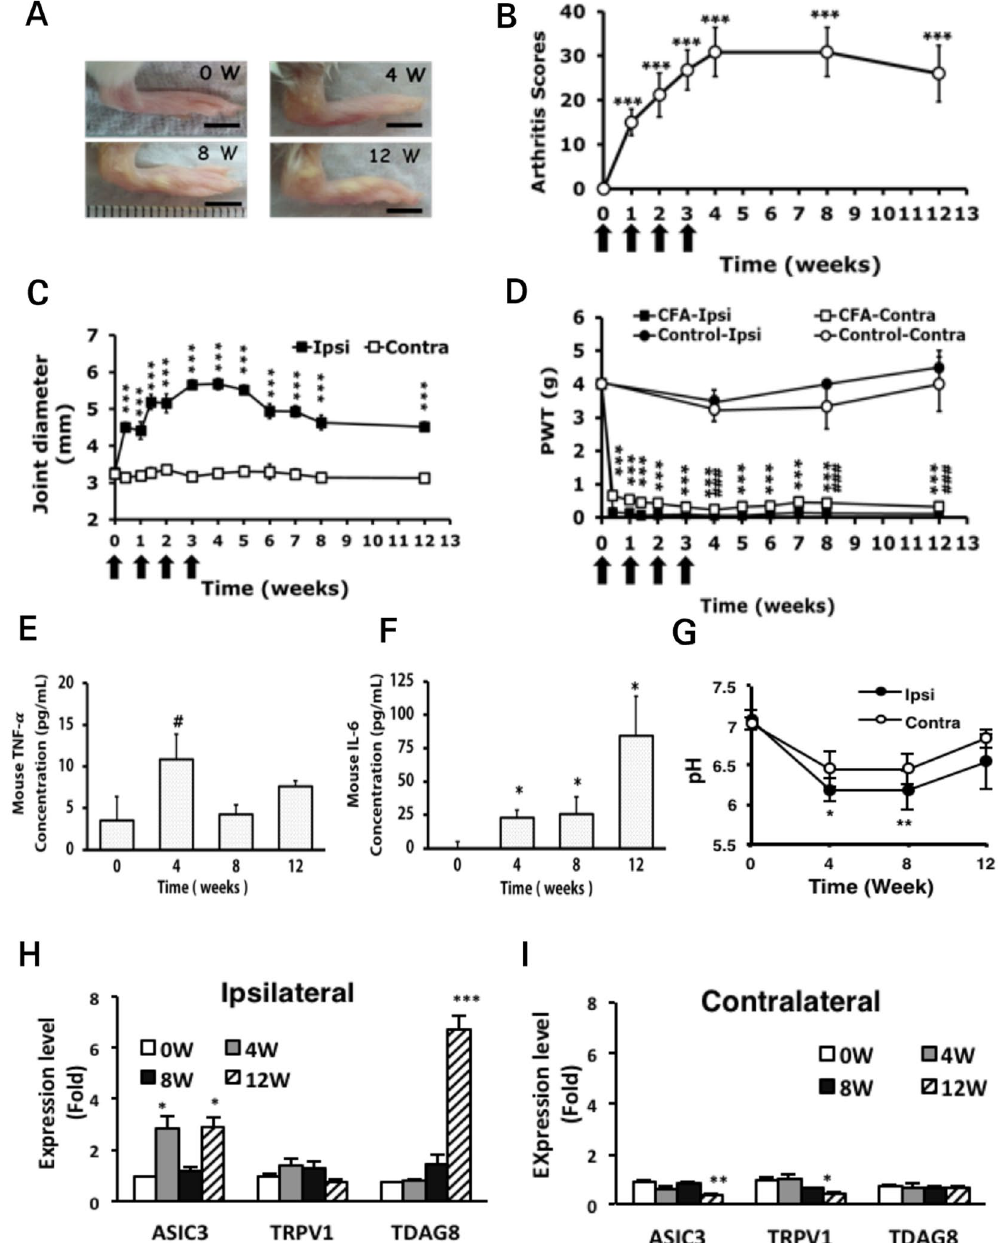
Figure 1. Arthritic ICR mice show long-lasting inflammation and bilateral mechanical hyperalgesia. Mice were injected with 5 μ g complete Freund’s adjuvant (CFA) in the right ankle joint (ipsilateral joint) once a week for 4 weeks. The joint swelling in 0, 4, 8, 12 weeks was photographed ( A ). Scale bar, 5 mm. ( B ) Severity of arthritis presented as arthritis scores. Arrows are CFA treatments. *** p < 0.001, compared with 0 week by one-way ANOVA. ( C ) Diameters of ipsilateral (ipsi) and contralateral (contra) ankle joints. *** p < 0.001, ipsilateral vs contralateral by two-way ANOVA. ( D ) Threshold of paw withdrawal (PWT) to mechanical stimuli measured at weekly intervals in CFA-injected or uninjected mice (control). Data are mean ± SEM of n = 6 mice with CFA injection and n = 3~8 mice without injection. *** p < 0.001, ipsilateral vs contralateral; ### p < 0.001, CFA-injected vs uninjected by two-way ANOVA. ( E ) Serum level of TNF α . # p < 0.05, compared with 0 weeks by nonparametric Mann-Whitney U test. ( F ) Serum level of IL-6. * p < 0.05, compared with 0 weeks by nonparametric Mann-Whitney U test. ( G ) pH value in synovial fluid in arthritic mice. Data are mean ± SEM. * p < 0.05, ** p < 0.01, compared with 0 weeks by one-way ANOVA. qRT-PCR analysis of gene expression in ipsilateral DRG ( H ) and in contralateral DRG ( I ). Data are mean ± SEM. * p < 0.05, ** p < 0.01, *** p < 0.001, compared with 0 weeks by one-way